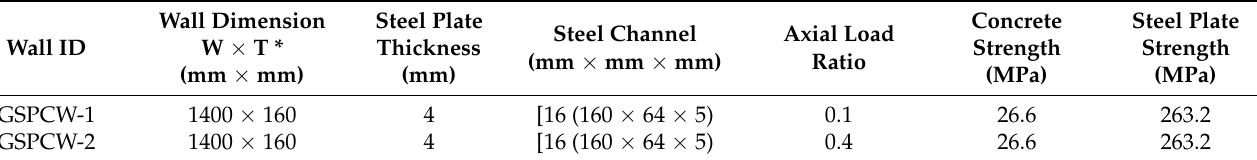
Figure 2. Tested GSPCW walls (adapted from [9]): ( a ) cross-section; ( b ) front view; ( c ) side view; ( d ) photo. Table 1. Design parameters for the wall specimens [9].